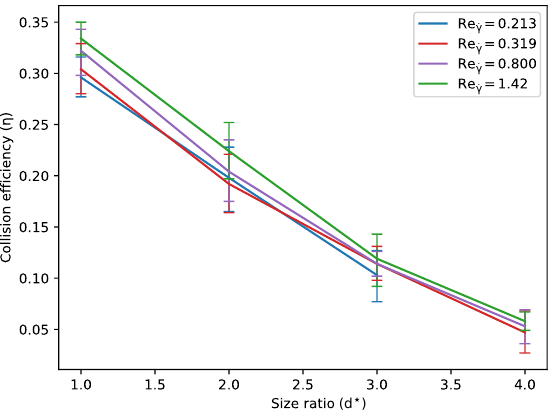
Figure 5. Collision efficiency from LBM simulations as a function of particle size